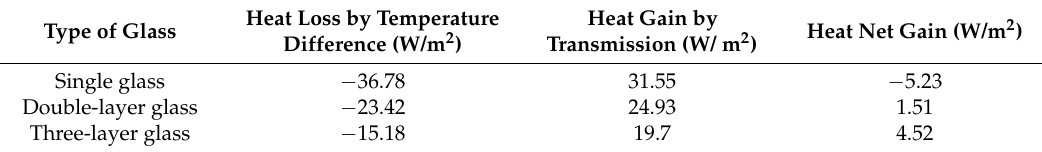
Table 2. Comparison of average accumulated thermal performance of different types of eastward and westward glass in the heating period (From 15th November to 15th next March) in Xi’an. Heat Loss by Temperature Heat Gain by Type of Glass Heat Net Gain (W/m 2 ) Difference (W/m 2 ) Transmission (W/ m 2 ) Single glass − 36.78 31.55 − 5.23 Double-layer glass − 23.42 24.93 1.51 Three-layer glass − 15.18 19.7 4.52